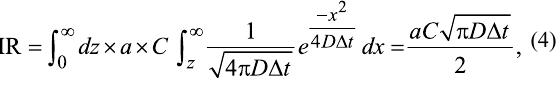
tion over all molecules in the solution represents the hitting rate (HR) of the molecules to a substrate (Figure 9):